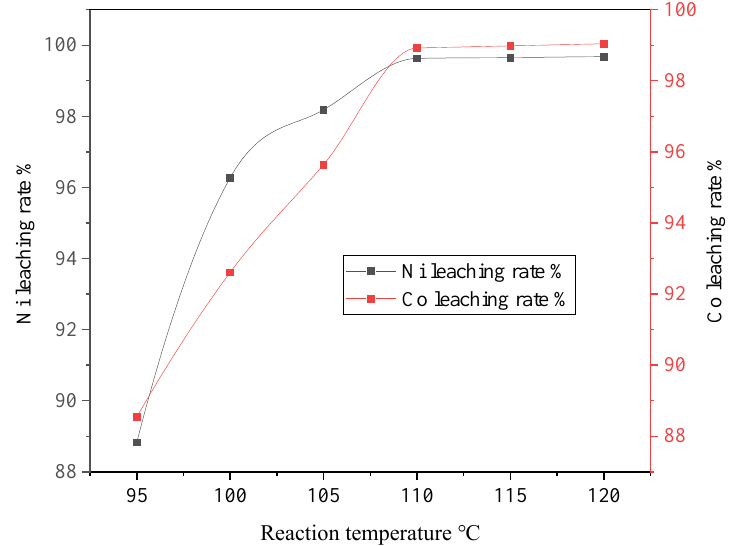
Figure 5. Effect of reaction temperature on the leaching rates of Ni and Co.